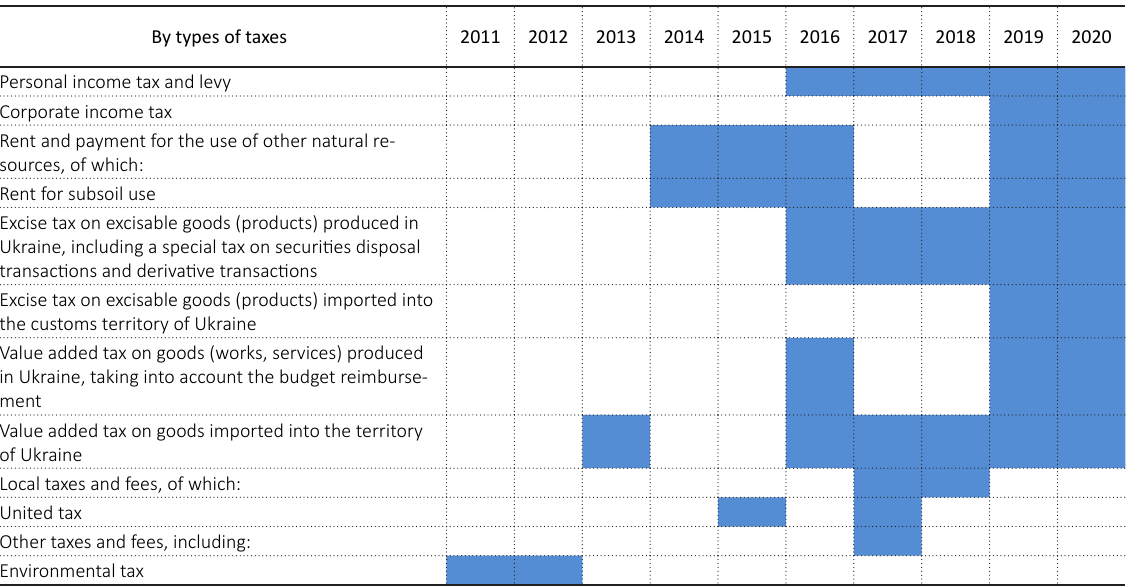
Table 2. P eriods of dissipation of tax revenues to the Consolidated Budget of Ukraine by different types of taxes